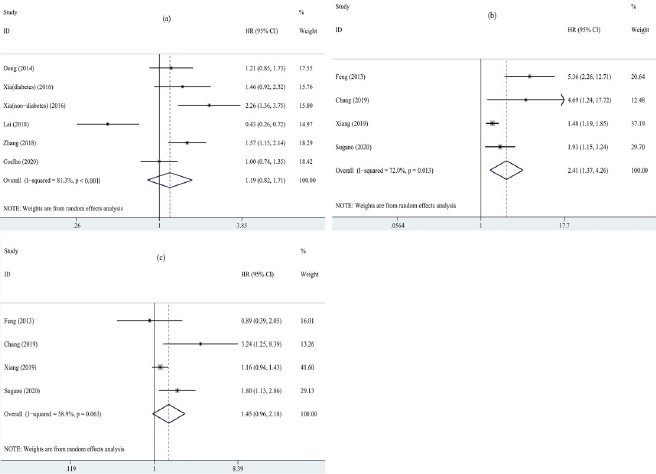
Fig 2. Forest plots for relationship between SUA and all-cause mortality in PD patients. (a) the highest SUA category versus the lowest. (b) the highest SUA category versus median. (c)the lowest SUA category versus median. SUA, serum uric acid; PD, peritoneal dialysis.